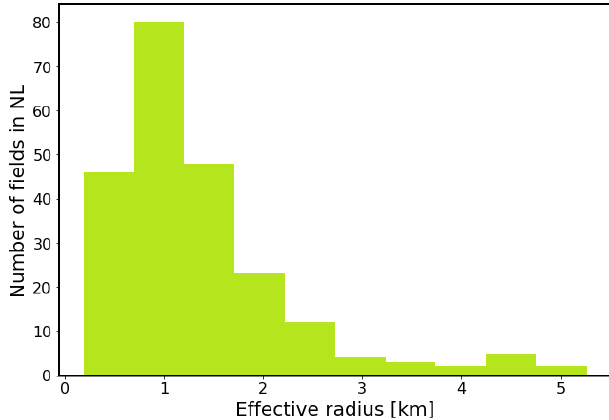
Figure 2. Distribution of the size of the gas fields in the Nether- lands, portrayed by their effective radius. With common reservoir depths of 2–3km, the bulk of the fields are sized well below twice their